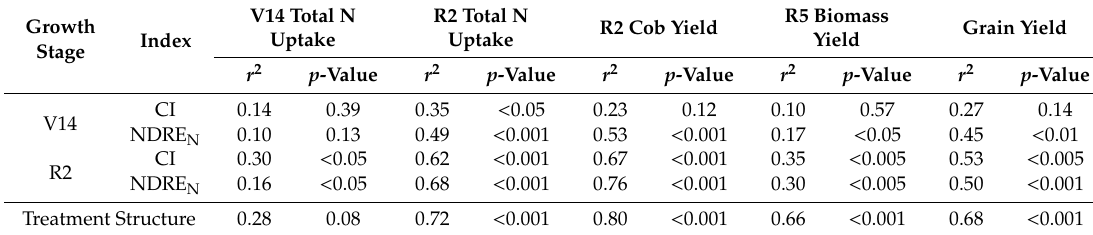
Table 6. Linear relationships of the Combined Index (CI) groupings, relative normalized di ff erence red edge (NDRE N ) alone, and the treatment structure to the 14th leaf stage (V14) total nitrogen (N) uptake, blister (R2) total N uptake, R2 cob yield, dent (R5) biomass yield, and final grain yield for the experimental site. r 2 = coe ffi cient of